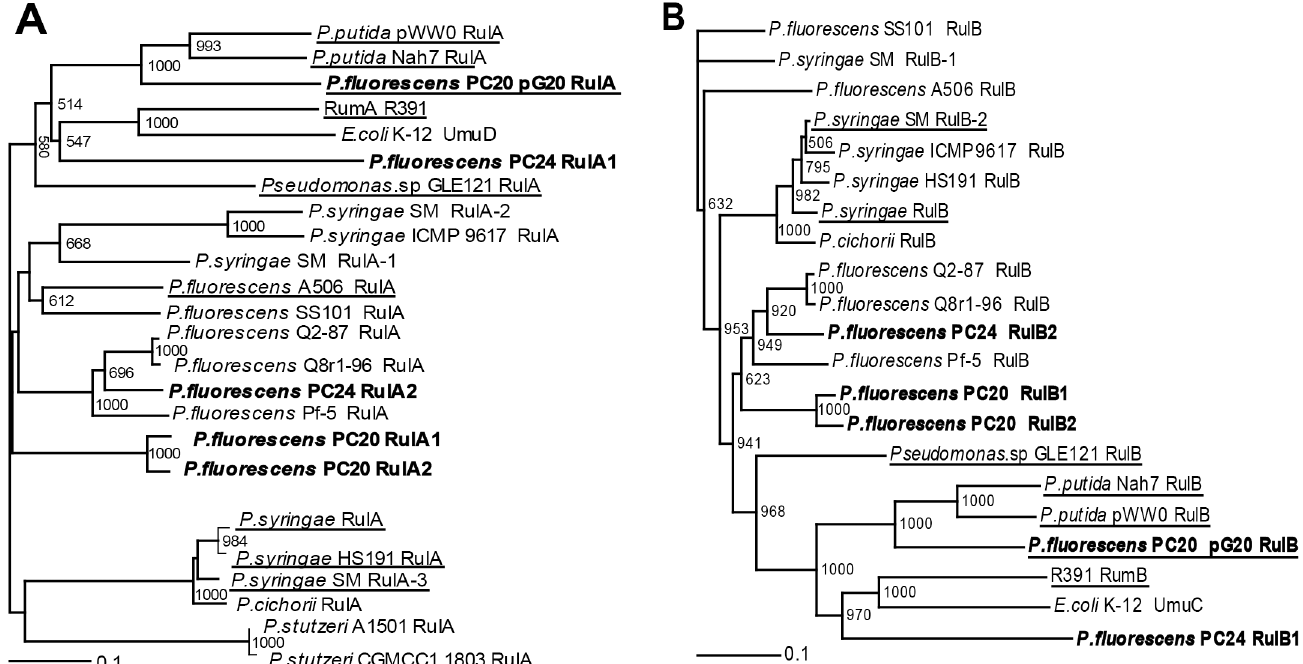
Fig 3. The phylogenetic trees of RulA (A) and RulB (B) protein sequences. Underlining indicates the genes of proteins which are located on plasmids. Sequencesderived from P . fluorescens strains PC20 and PC24 are shownin boldface.Sequences were alignedwith ClustalX2and further visualisedwith TreeViewX. Numbers at branch nodes indicatebootstrapping values for 1000bootstrap replicates. Values under 500 were removed. The identifiersof the alignedsequencesare presentedin S7 Table.